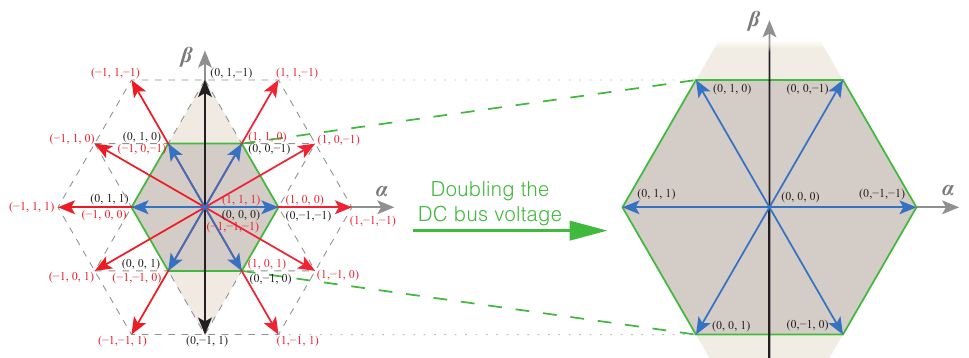
Figure 4. Available voltage vectors and modulation area after hardware reconfiguration in phase R , when the DC bus voltage is doubled.